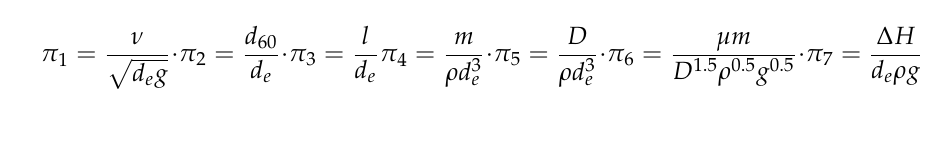
Table 4. Dimensional matrix for parameter